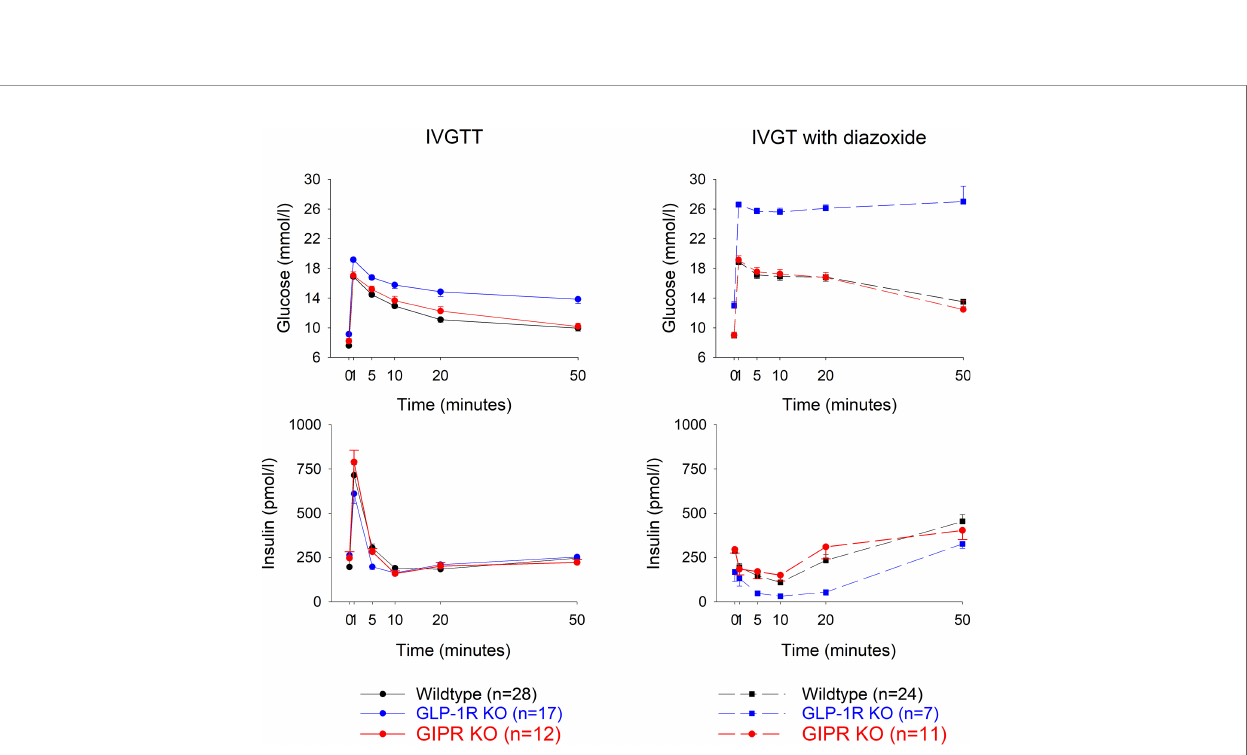
FIGURE 1 | Glucose and insulin levels after intravenous injection of glucose (0.35g/kg; left panels) or after oral administration of glucose (75 mg; right panels) in C57BL/6J mice during anesthesia with Hypnorm R /midazolam or Fluafent/midazolam. There were 12 animals in each of the four study groups. Means ± SEM are shown.